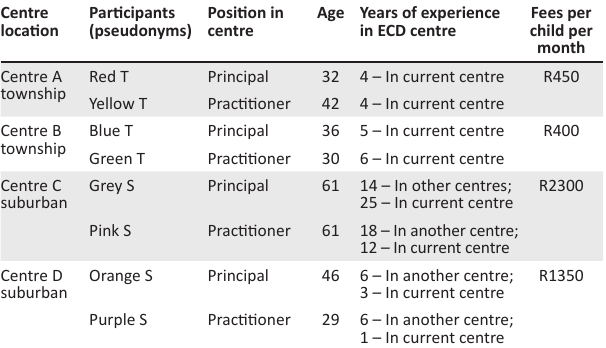
TABLE 1: Biographic information of centres and